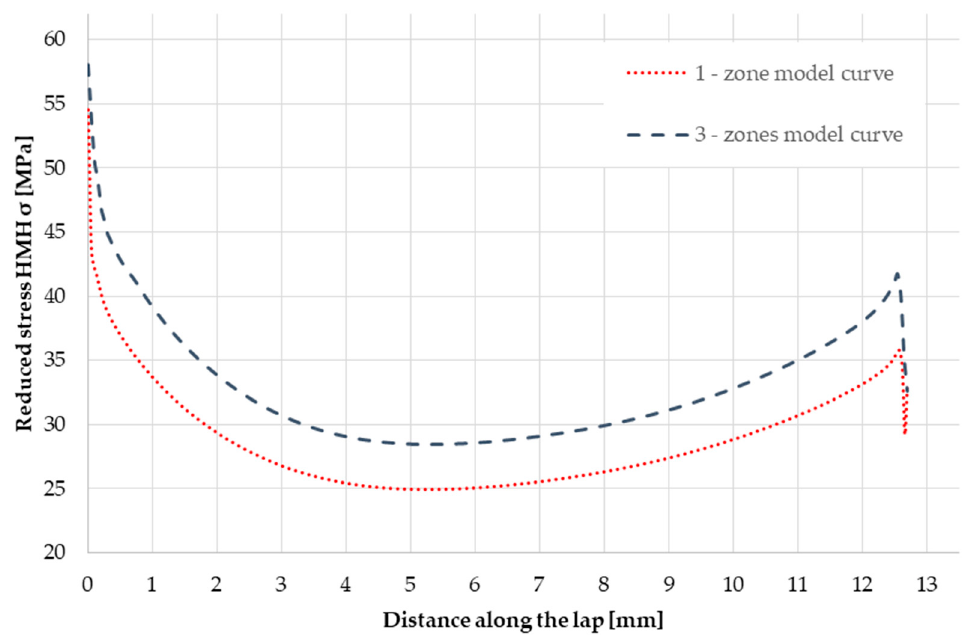
Figure 7. Comparison of reduced stress along a single 12.7-mm long lap.